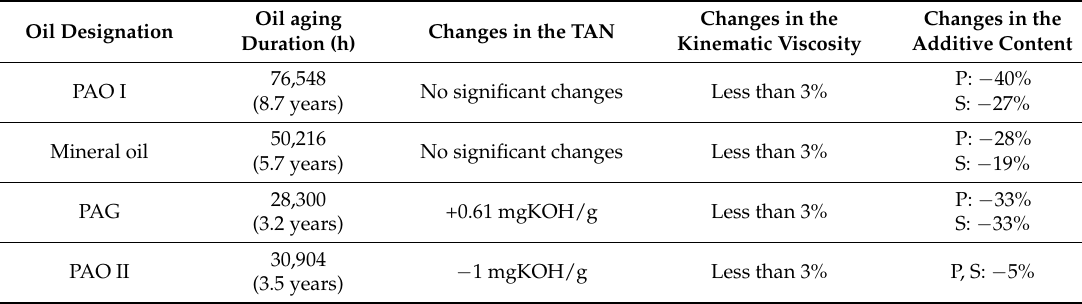
Table 5. Results of the field